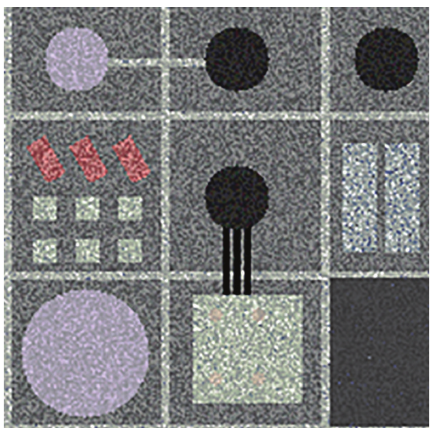
Figure 4: Absorptive coefficient spectra of sulfur dioxide (blue curve) and ammonia (red